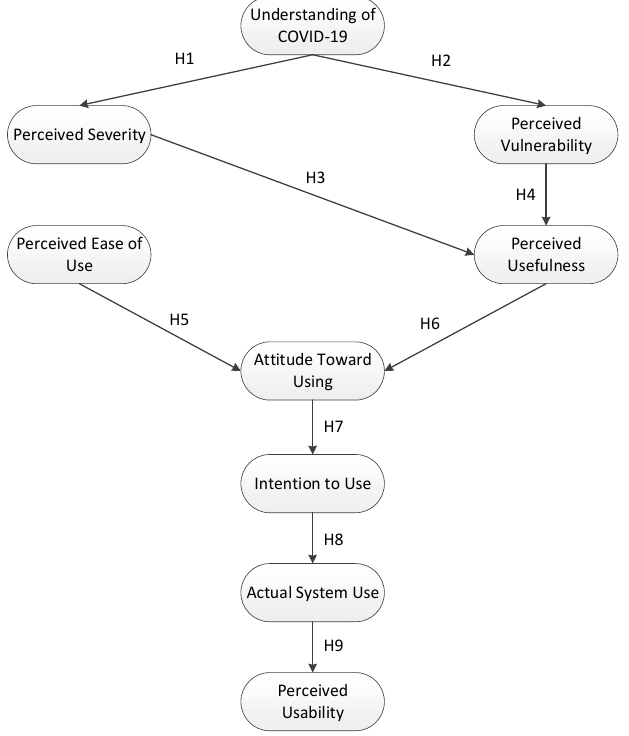
Figure 2. Conceptual